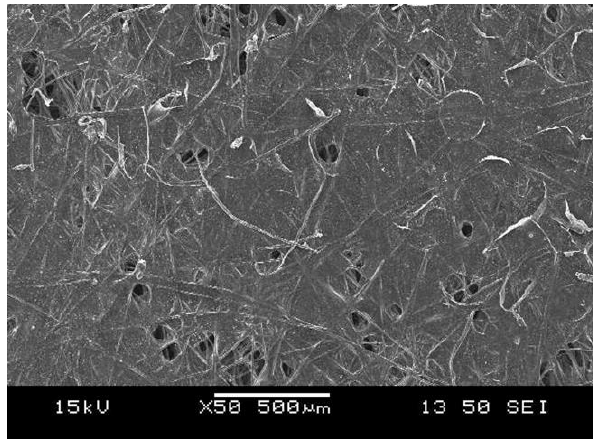
Figure 17. SEM image of SWCNT film integrated into a carbon fiber paper current collector. Carbon fibers of ~10 μm diameter and >50 μm porosity coated and filled with functionalized SWCNTs .